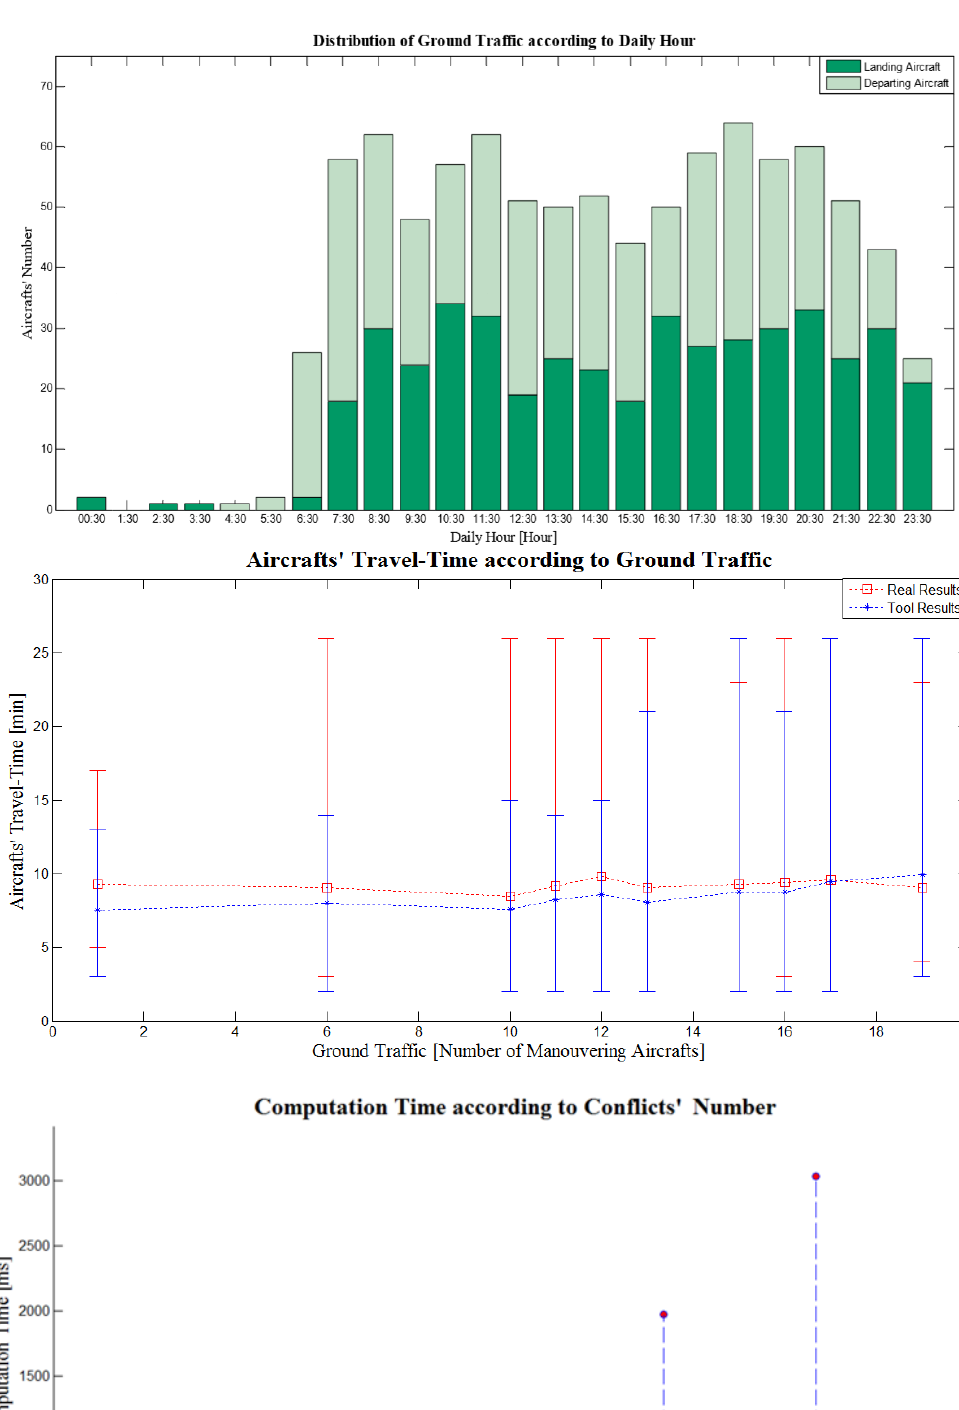
Figure 8. XRP preliminary validation: traffic sample ( top ), aircraft travel-Time ( middle ), and computational time ( bottom ). (source: